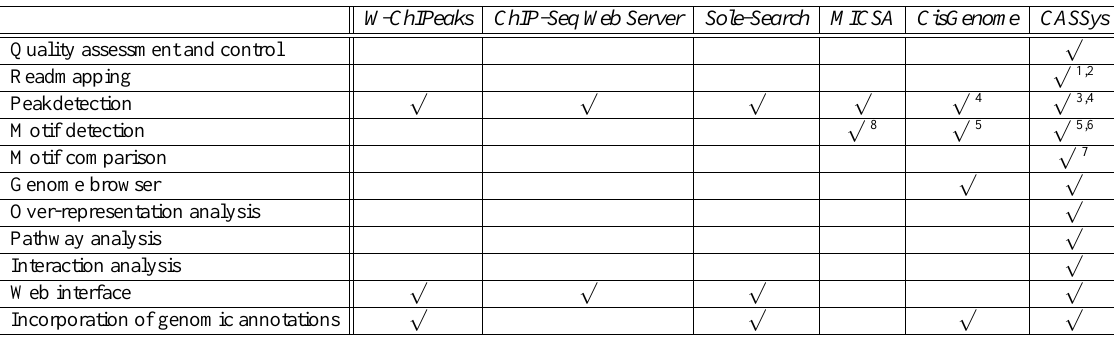
Table 1: Most ChIP-seq analysis pipelines focus on providing a graphical user-interface for peakdetection and hardly offer further analysis capabilities following this step. Except for CASSys , no system supports readmapping as well as peakdetection, which are absolutely necessary for anal- ysis of ChIP-seq data. In addition, CASSys offers an integrated QA/QC processing step and the widest range of possible follow up analyses. Hence, it supports the whole computational data anal- ysis ranging from the processing of raw reads to follow up analyses like motif detection, pathway analysis and interaction network